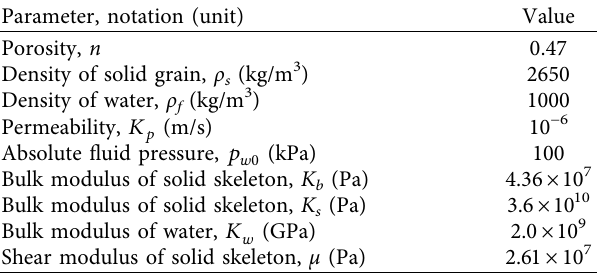
Table 1: Soil properties used in theoretical